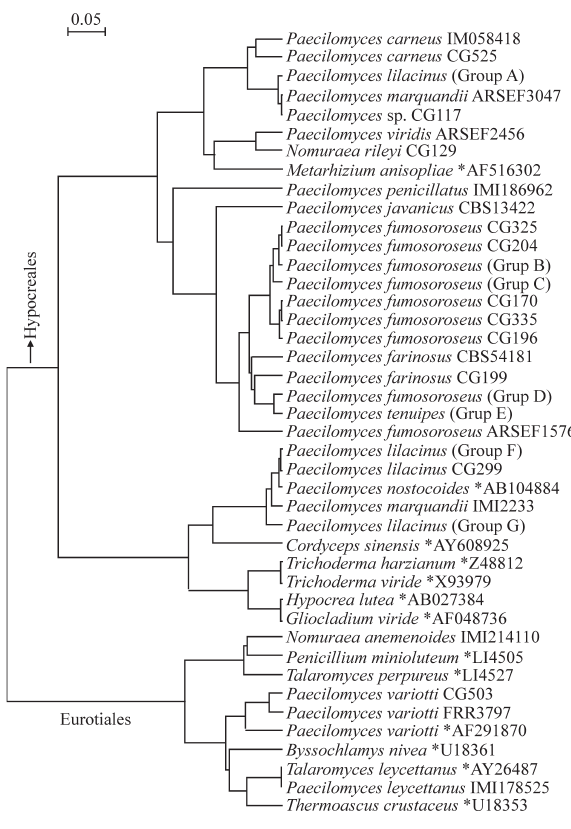
Figure 1 - Phylogenetic tree for Paecilomyces species based on internal transcribed spacer (ITS) and 5.8S rDNA sequences using the Maximum Likelihood with molecular clock method. The ascomycetous classes are indicated on the major branches. Sequence divergence is indicated by the scale bar. Samples giving identical ITS1-5.8S-ITS2 gene sequences were assigned to an arbitrary group and are represented in the tree by their group/species designation. Strains marked with an asterisk* are GenBank accessions not sequenced in the study. The tree and its data matrix have been submitted to